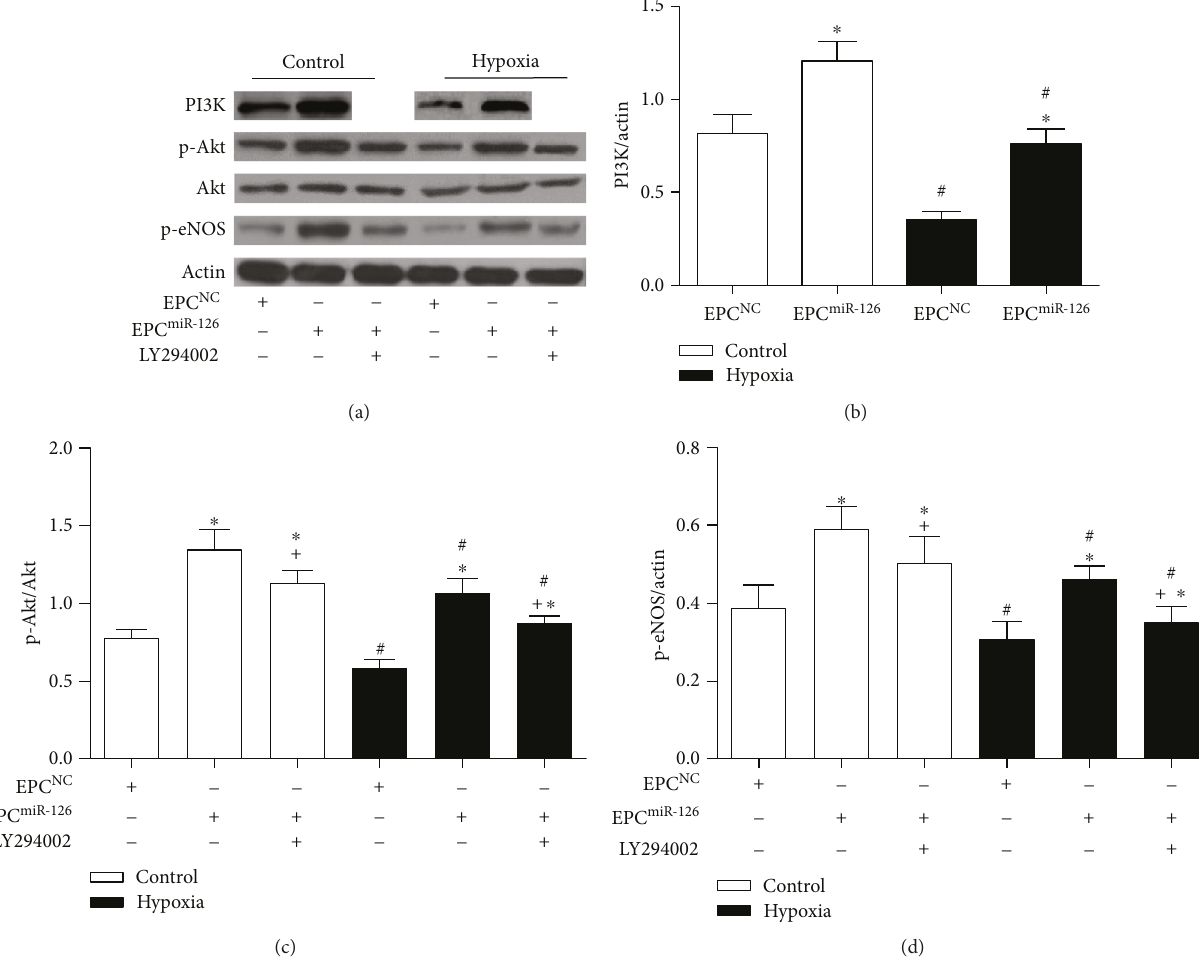
Figure 4: E ff ects of miR-126 overexpression on the expression of PI3K, p-Akt/Akt, and p-eNOS in EPCs and hypoxia-injured EPCs. (a) Western blot showing expression of PI3K, p-Akt/Akt, and p-eNOS of EPCs. (b – d) Summarized data on the expression of PI3K, p-Akt/ Akt, and p-eNOS. ∗ p < 0 05 versus EPC NC ; + p < 0 05 versus EPC miR-126 ; # p < 0 05 versus control, n = 3 /group.